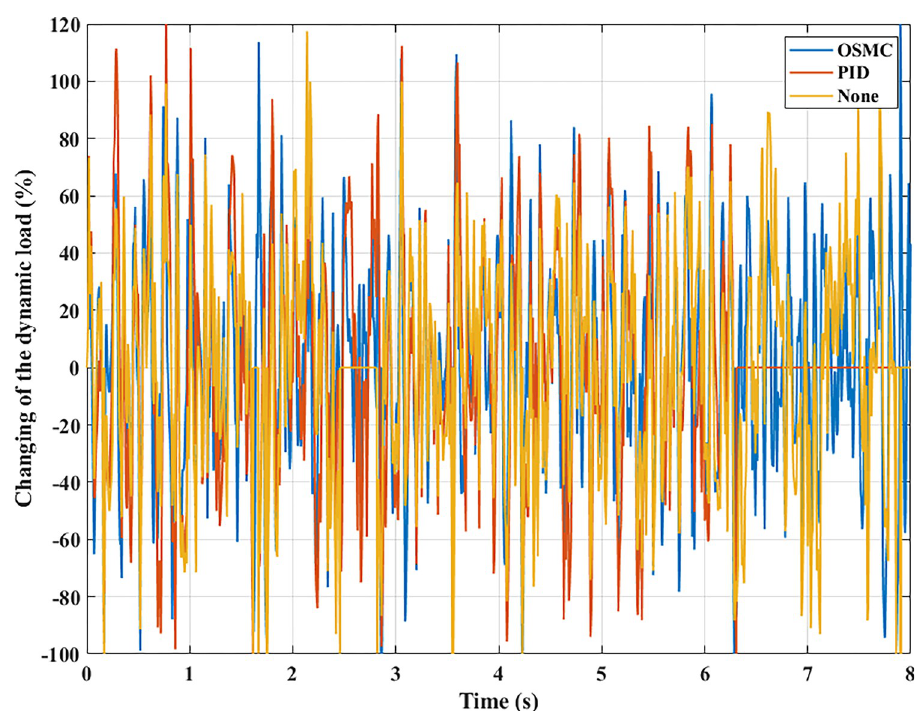
Fig 19. Changing the dynamic load (case 3).